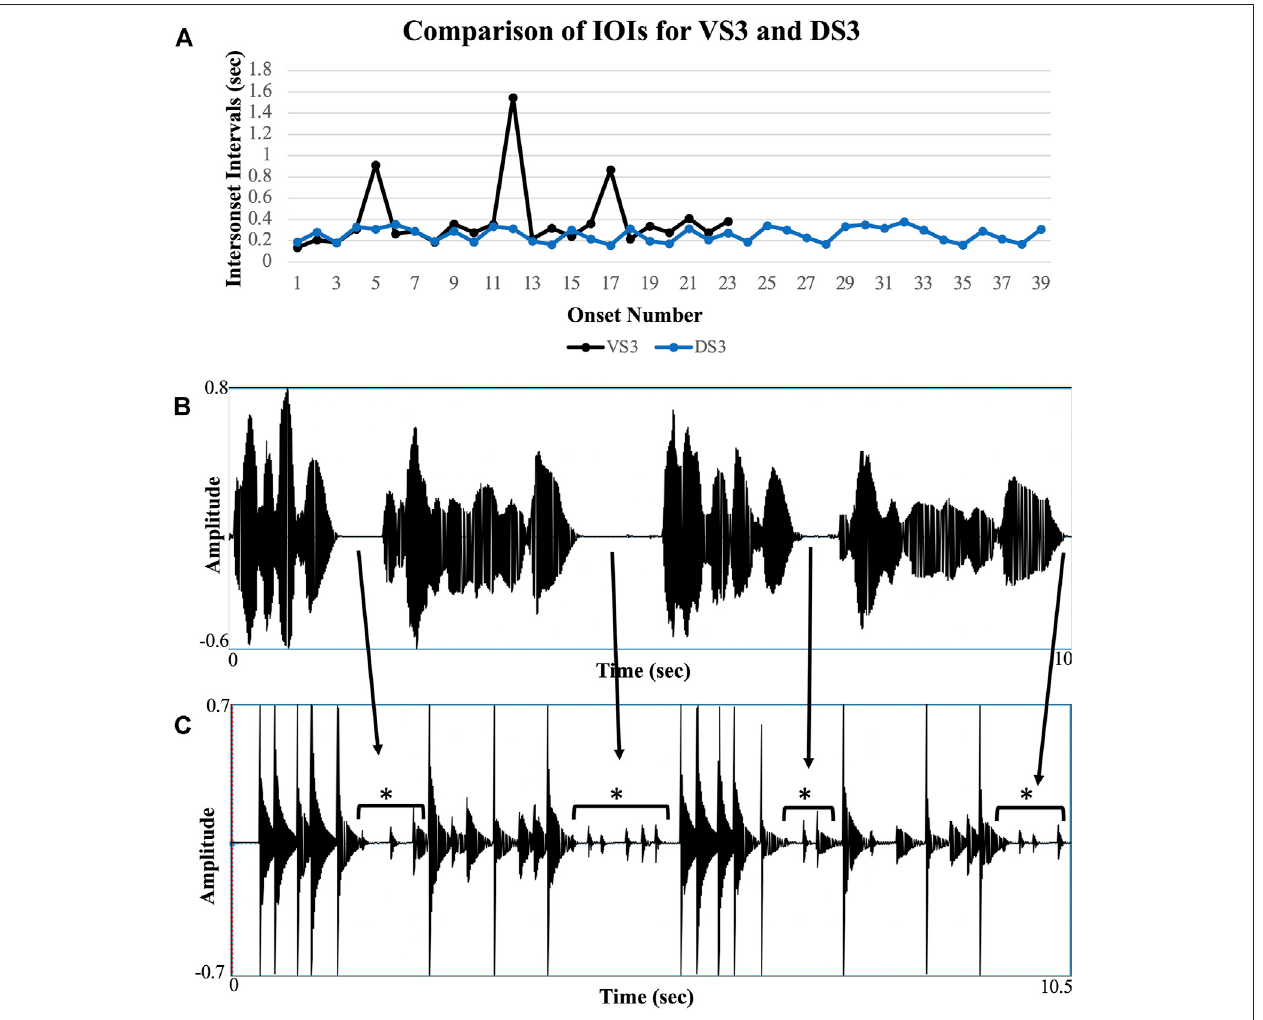
FIGURE8| ExampleofthetemporalacousticcorrespondencebetweenatypicalVSandDSsamplephrase.Shownaresoundpressurelevelsduringavoice-drum sequence of about 10 s (A) IOI timing pattern of a matched set of VS and DS sample phrases (see sound samples Supplementary Samples 5A,B ). (B) Temporal acoustic intensity graph for the VS sample. (C) Temporal acoustic intensity graph for the DS sample. Note how the two samples have approximately the same discrete onsets (syllables or drum strikes, respectively) and rate, but that the DS sample has more onset, particularly between sub-phrases consisting of quieter, repeating patterns of attacks that maintain a rhythmic musical time-keeping structure (exemplars marked with an asterisk).